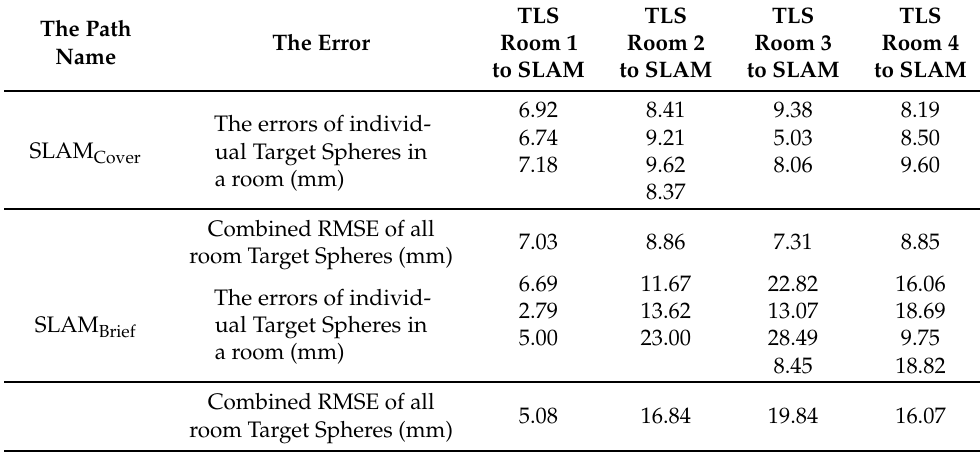
Table 5. The errors of Target Sphere of the TLS rooms’ registration with SLAM LS support and the combined root mean square error (RMSE) of all Target Spheres. For the SLAM Cover path, we used three target spheres in Rooms 1, 3, and 4; and for the SLAM Brief path, we used three target spheres in Rooms 1 and 2. Other alignments were used for four target spheres.